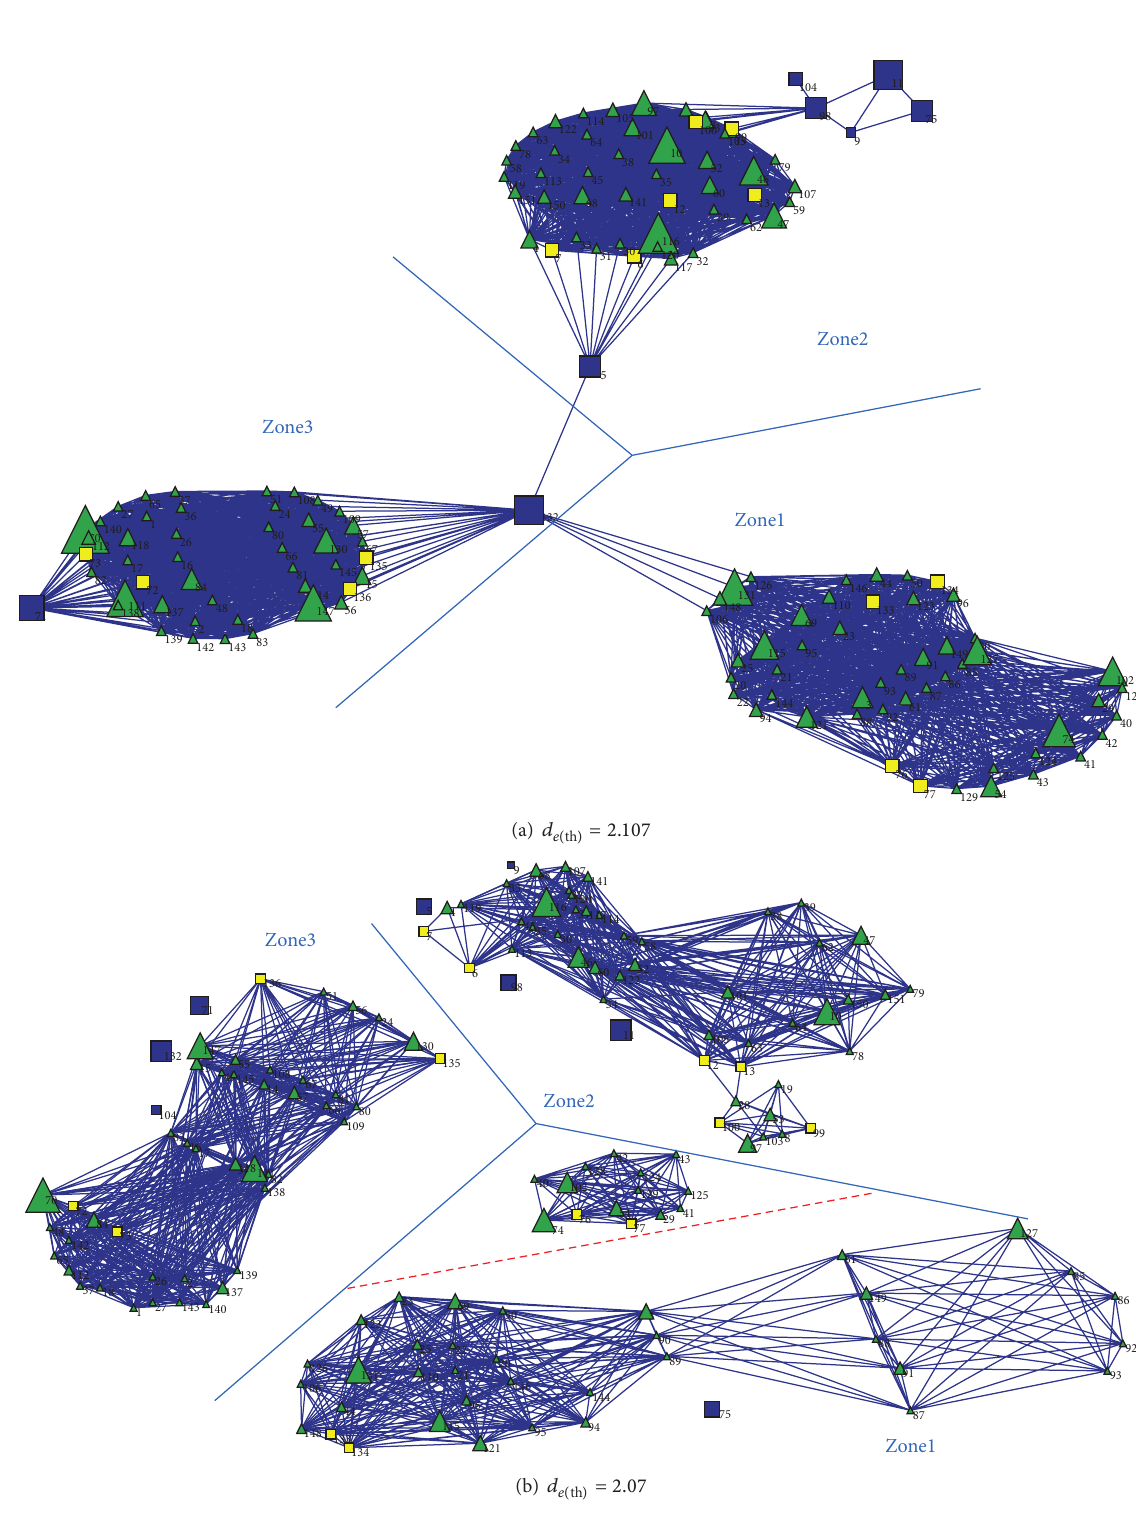
Figure 9: Structure of electrical distance-based model of TJ220